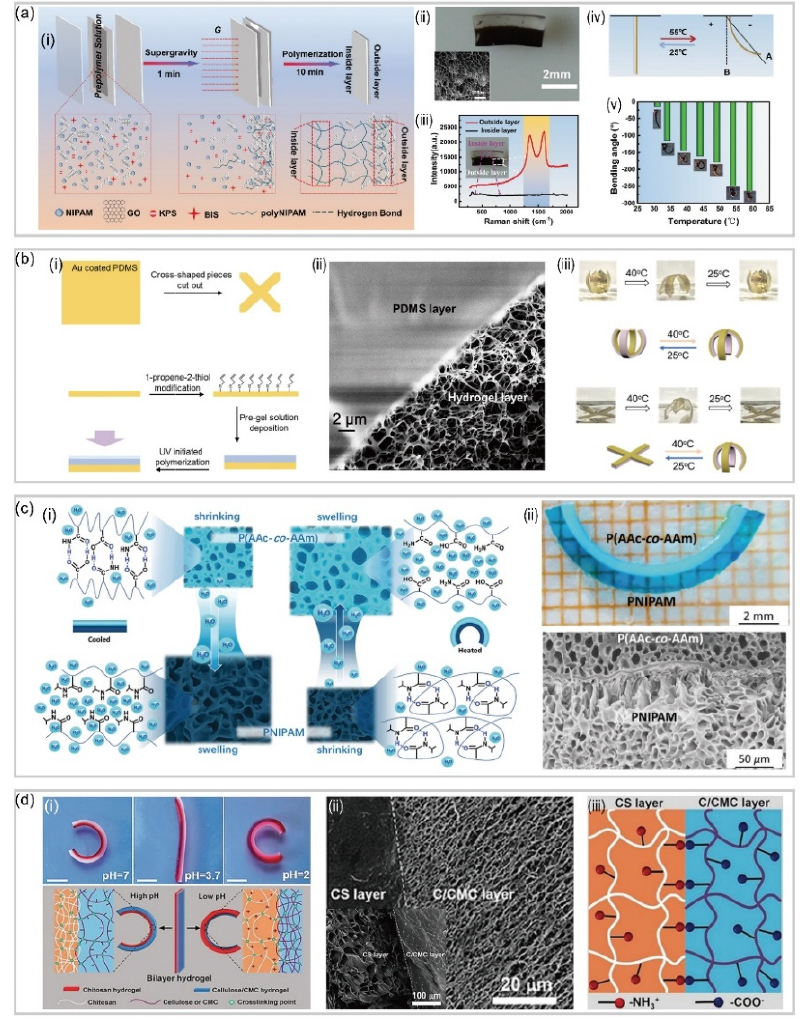
Figure 4. Bilayer-based hydrogel soft robotics. ( a ) Bilayer poly (N-isopropylacrylamide)/graphene oxide (pNIPAm/GO) hydrogel actuator (reproduced with permission from Reference [58]). ( b ) Tem- perature and pH responsive hydrogel actuator and its SEM image of the interface of the two layers (reproduced with permission from Reference [62]). ( c ) The microstructure and deformation mecha- nism of mimosa-inspired hydrogel actuator and SEM image showing the bilayer structure tightly joined by a 5 μ m interfacial layer (reproduced with permission from Reference [63]). ( d ) Schematic self-bending deformation of the pH responsive bilayer hydrogel actuator and the SEM image of the cross-section of the bilayer hydrogel (reproduced with permission from Reference [64]).